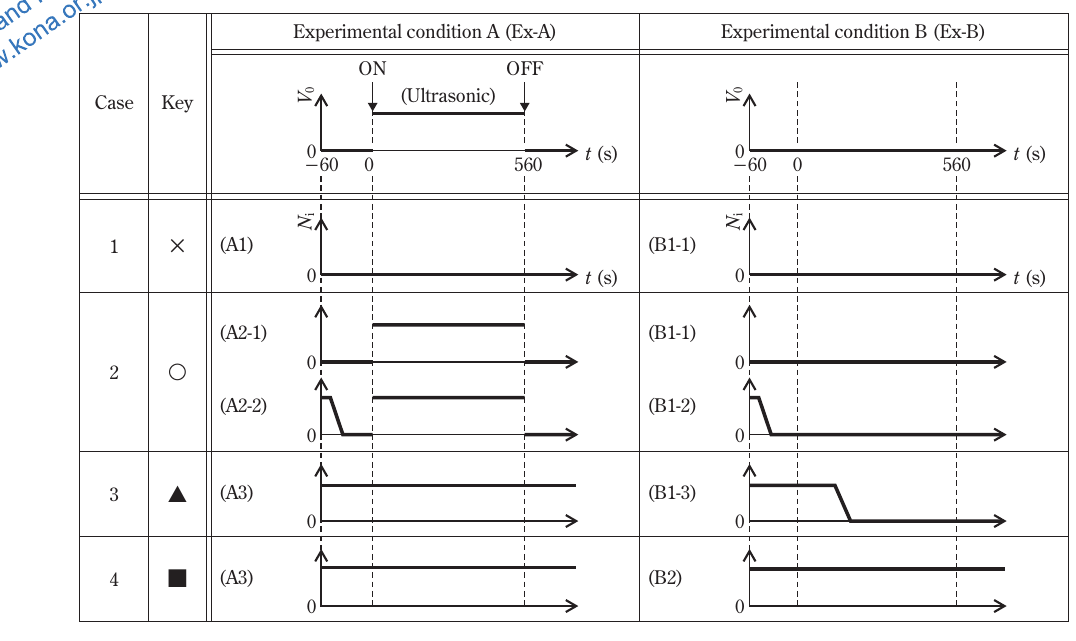
Fig. 2 Particle discharge characteristics, Case-1 to Case-4, classified on the basis of the combination of respective N i variations (A1-A3 vs. B1 and B2) obtained under the experimental conditions, Ex-A and